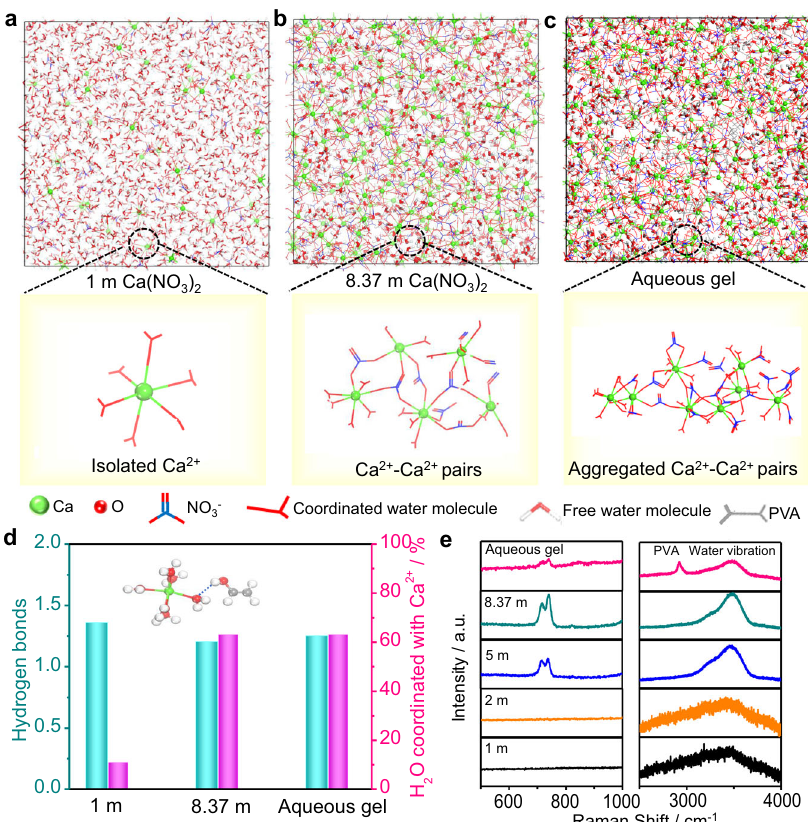
Fig. 2 Molecular dynamics simulations and characterization of electrolytes. Snapshots of local structure evolution for a 1 m Ca(NO 3 ) 2 electrolyte, b saturated Ca(NO 3 ) 2 electrolyte, and c aqueous gel electrolyte based on MD simulation at 10 ns. d The hydrogen bonds and the percentage of water molecular coordinated with Ca 2 + for three electrolyte samples based on MD simulation at 10 ns. The hydrogen bond between the Ca 2 + – H 2 O complex and PVA repetitive unit is shown in the inset. The green, red, white, and gray balls represent Ca, O, H, and C, respectively. e Raman spectra of the 1 m, 2 m, 5 m and saturated Ca(NO 3 ) 2 aqueous electrolytes, and aqueous gel